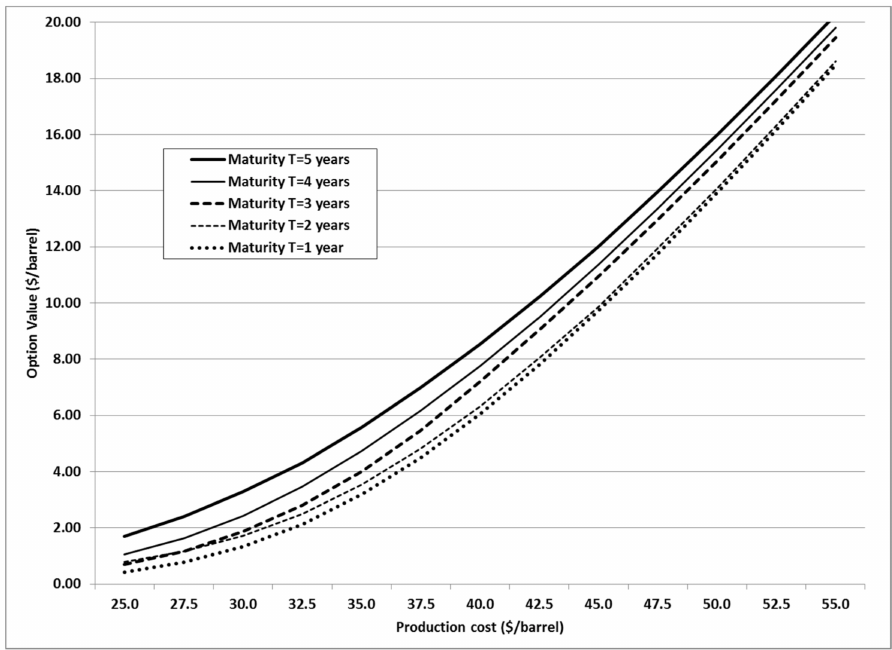
Figure 8. Value of abandonment option as a function of production cost and option